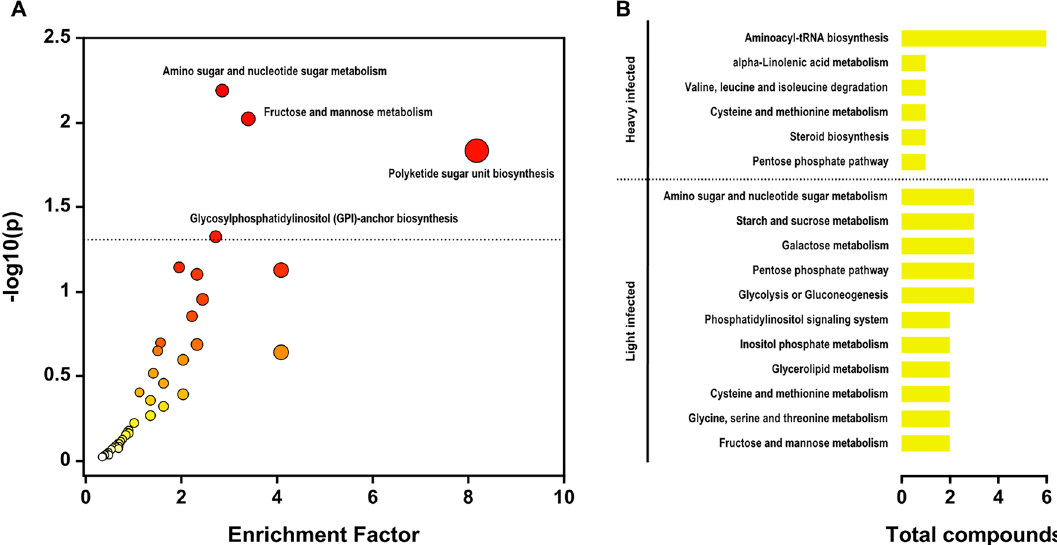
Figure 4. Metabolite annotation and pathway analysis using Mummichog. ( A ) Pathway enrichment is based on altered metabolites in both the heavy and light infected ascariasis groups. ( B ) Pathway enrichment and proportion of compound metabolites were shown separately in the heavy and light infected